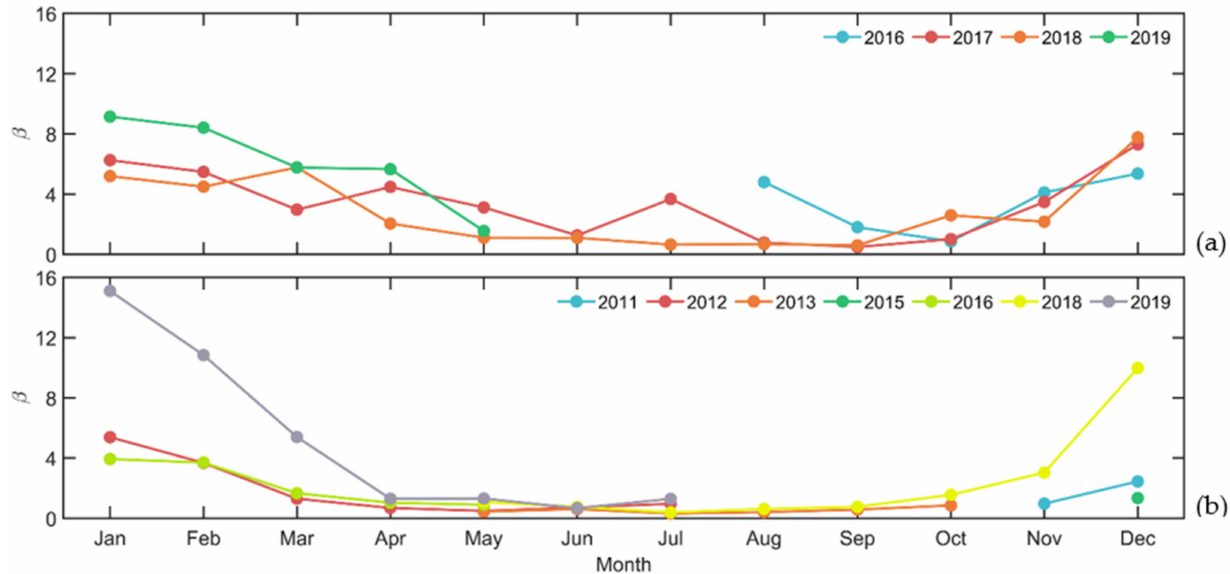
Figure 9. Seasonal variation in β in Dingxi ( a ) and Qingyang ( b